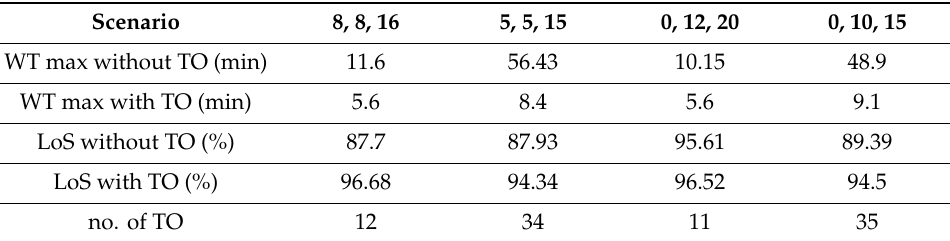
Table 4. Comparison of maximum WT, LoS, and number of users lost for the models with and without TO for 23 min charge